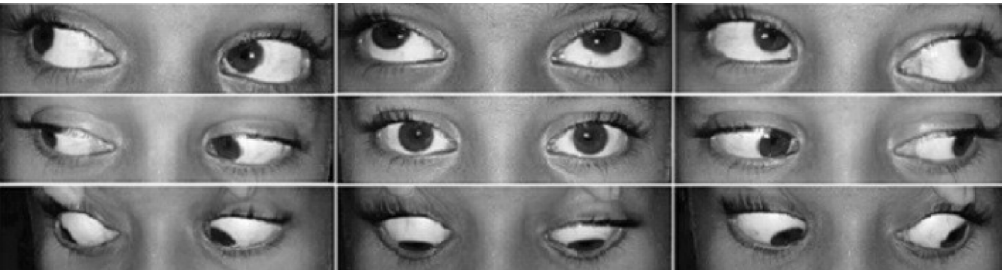
Figure 3: At 2 weeks post-treatment, position of the patient’s eyes in all the gazes showing complete ocular movement At 2 weeks review, a complete symptomatic as well as clinical improvement was noted (Figure